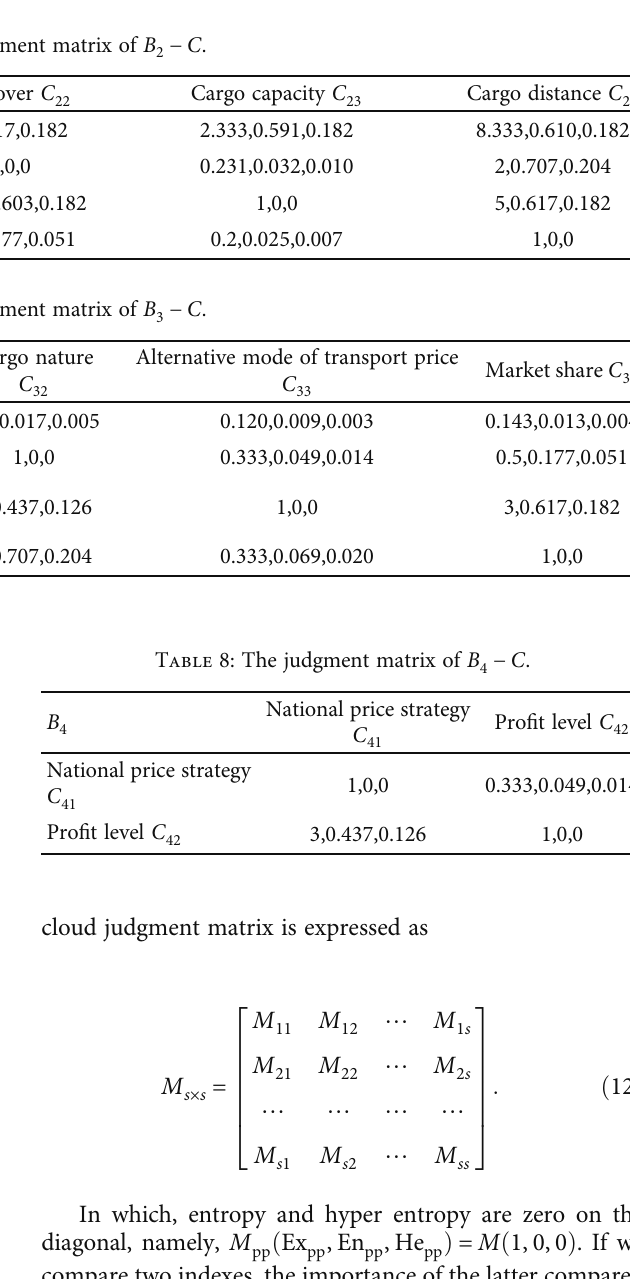
Table 6: The judgment matrix of B